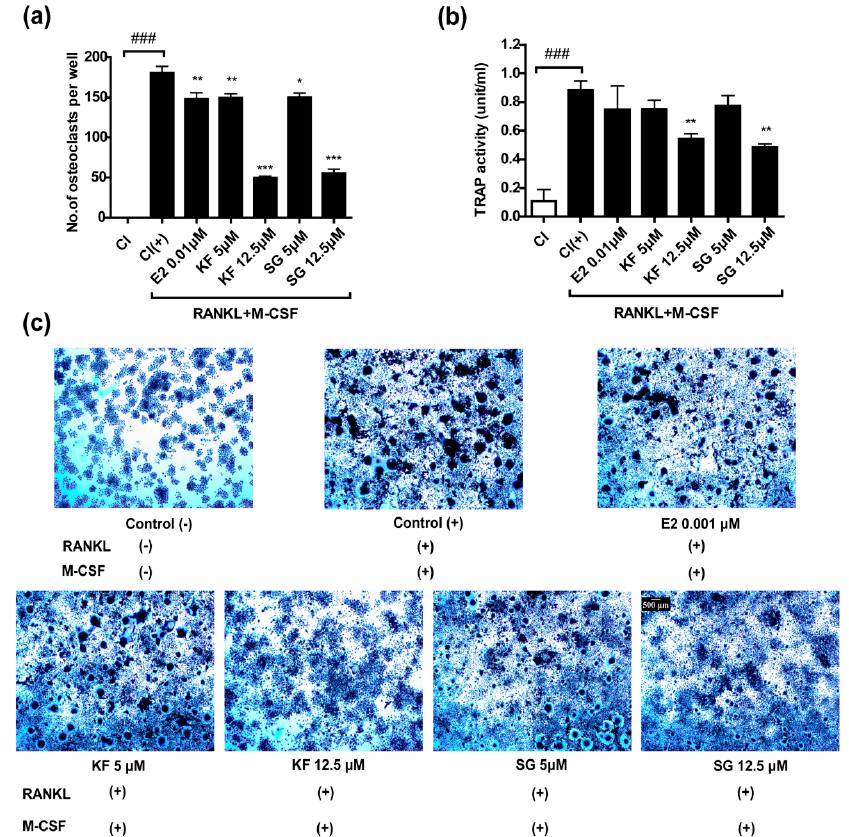
Figure 4. Inhibitory activities of Kushennol F (KF) and Sophoraflavone G (SG) on RANKL-induced RAW264.7 osteoclastogenesis. ( a ) Number of mature osteoclasts TRAP-positive